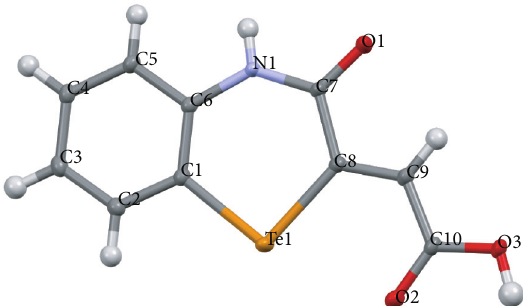
Figure 9: ORTEP plot of (Z)-2-(3-oxo-3,4-dihydro-2(H)-benzo [(b)][1,4]tellurazin-2-ylidene)acetic acid 5 .